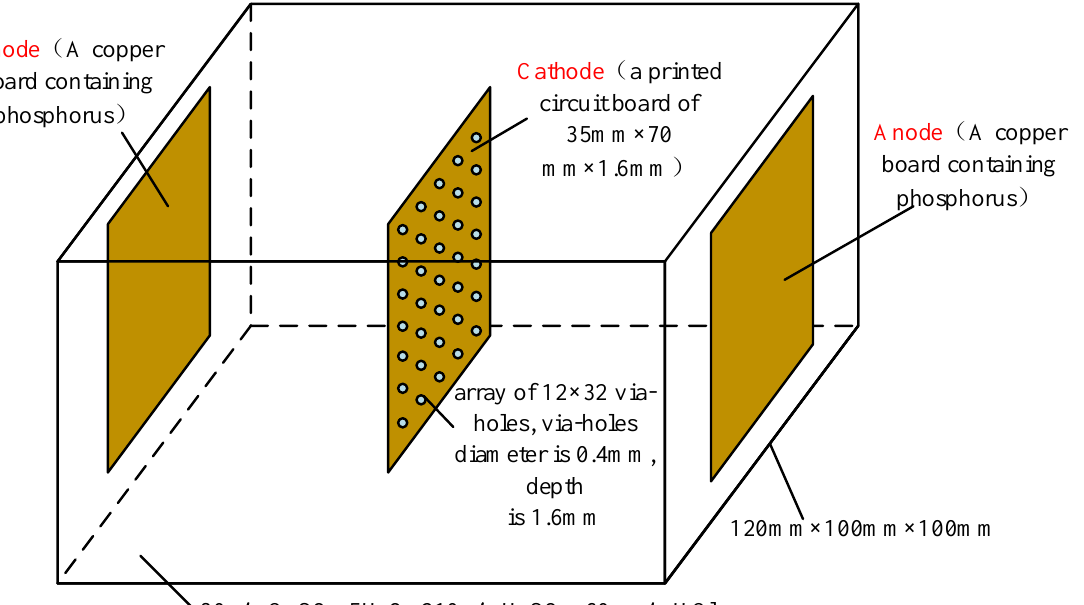
Figure 7. Electroplating tank model diagram. 4.1. Comparison of The Effects of Pulse Plating and DC Plating on Via-Filling Copper Plating The samples were scanned using a Quanta 250 scanning electron microscope